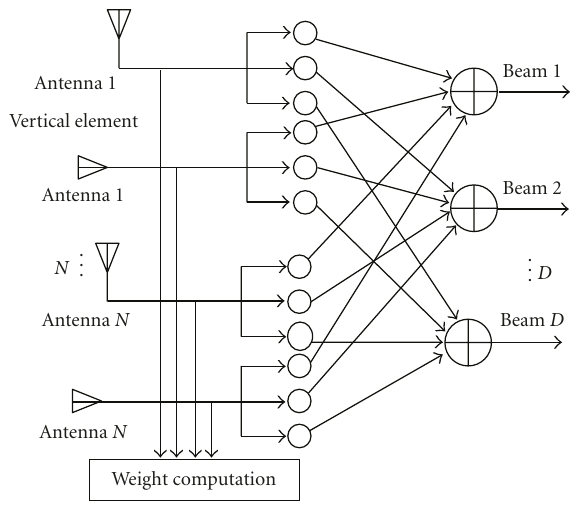
Figure 2: Block diagram of the multiple MVDR